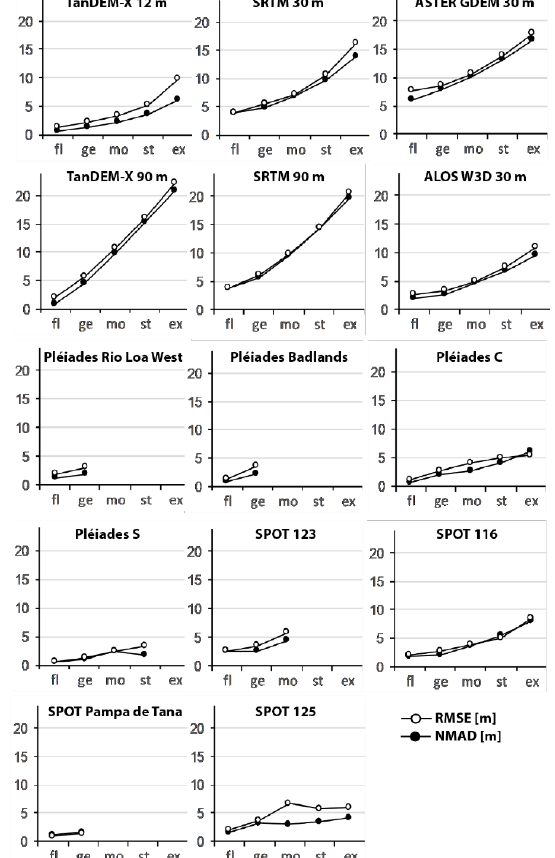
Figure 3. Calculated RMSE and NMAD of elevation differences according to the slope. Derived slope classes are flat (fl), gentle (ge), moderate (mo), steep (st) and extreme